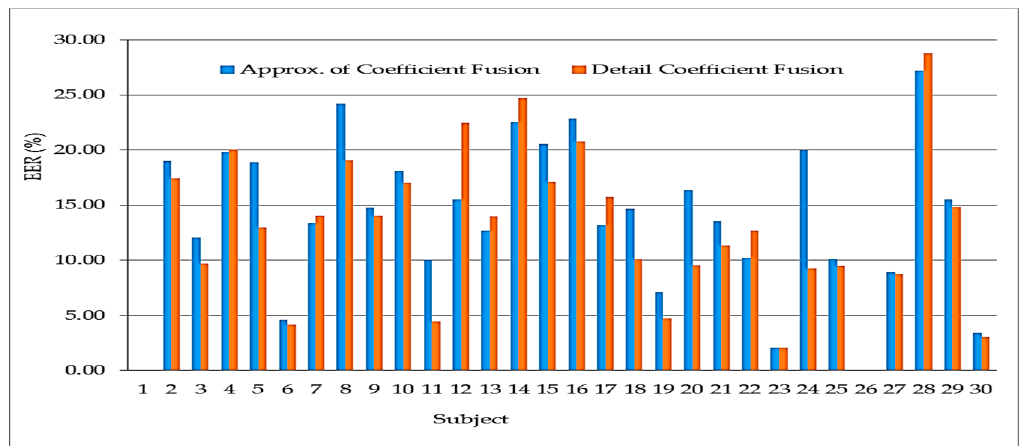
Figure 17. Result showing the verification of the data from 30 subjects using fusion of approximation and detail coefficient sub-bands.